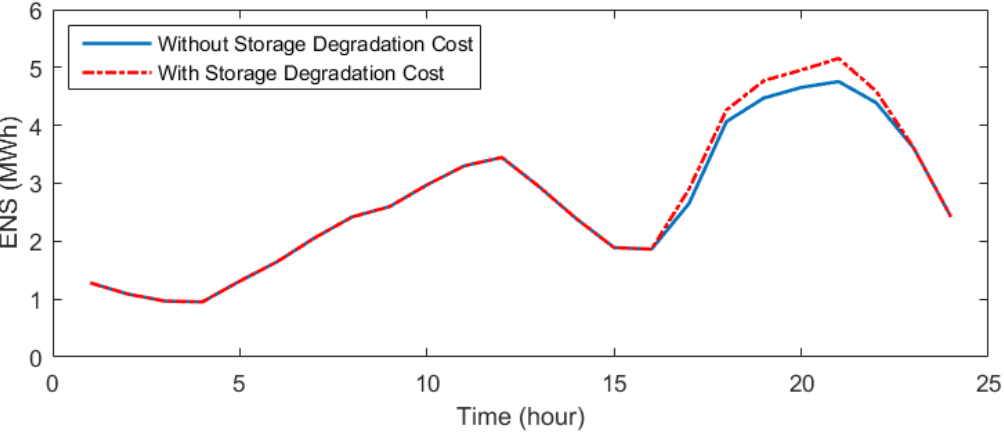
Figure 14. ENS of the network without and with BDC in WT/Battery scheduling using the IFLA.